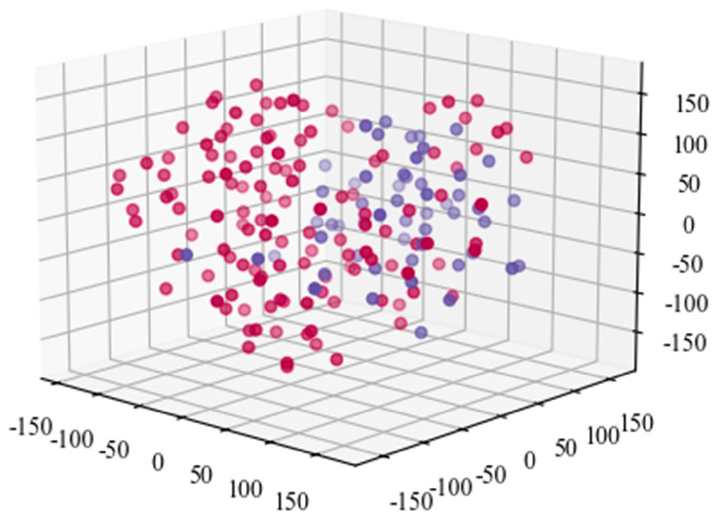
Figure 17. The diagram of the extracted acoustic signal characteristic data after TSNE processing.